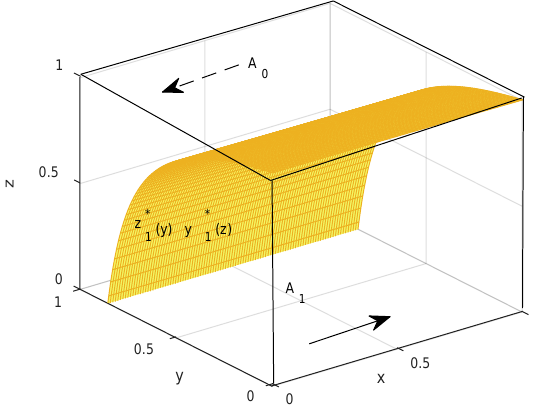
Figure 1. Behavior evolution direction of the local government.